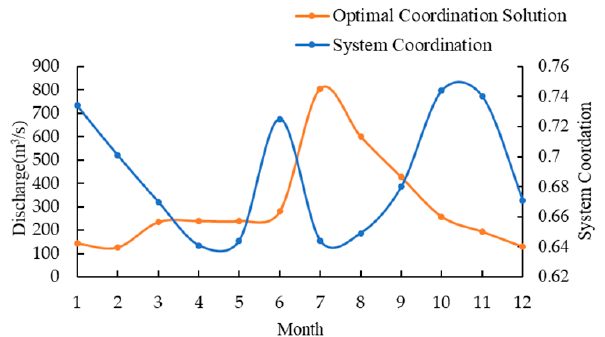
Figure 8. Maximum system coordination and optimal coordination solution by month.